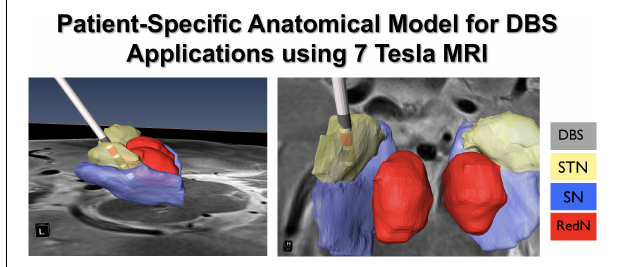
FIGURE 10 | Patient specific modeling for